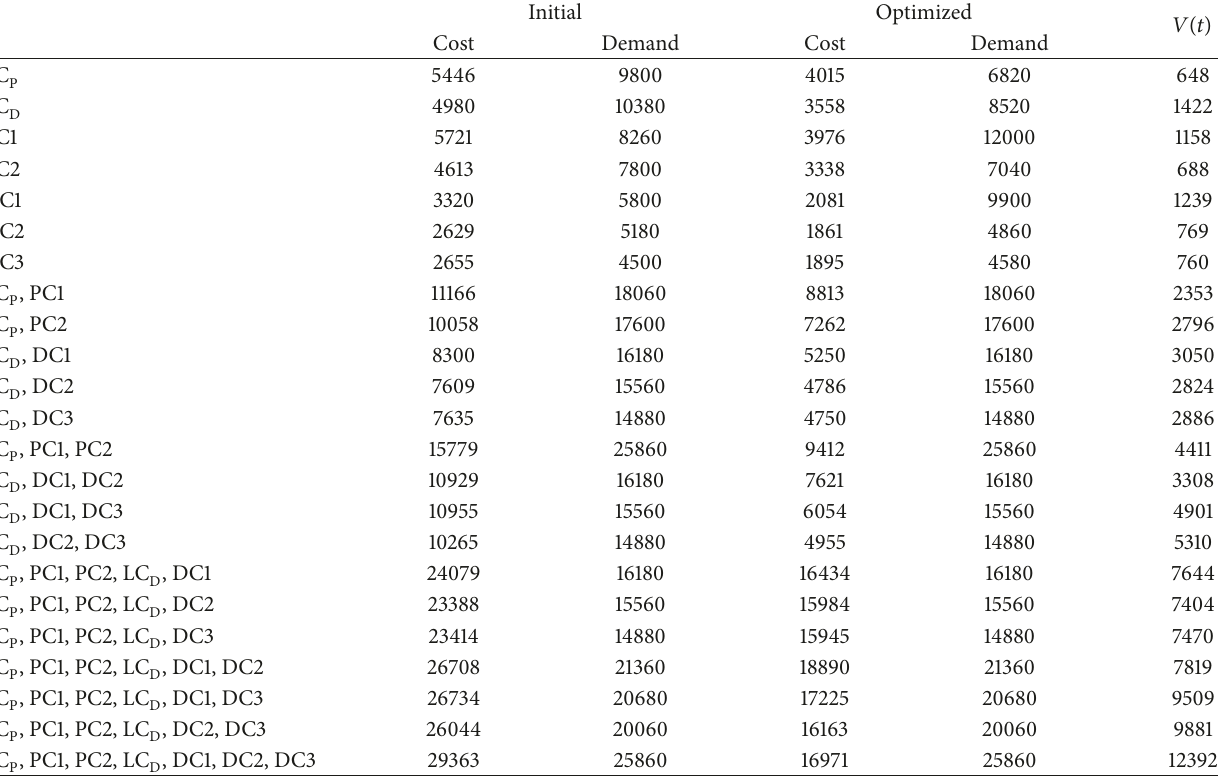
Table 3: Comparison between initial and optimized network over one working period.